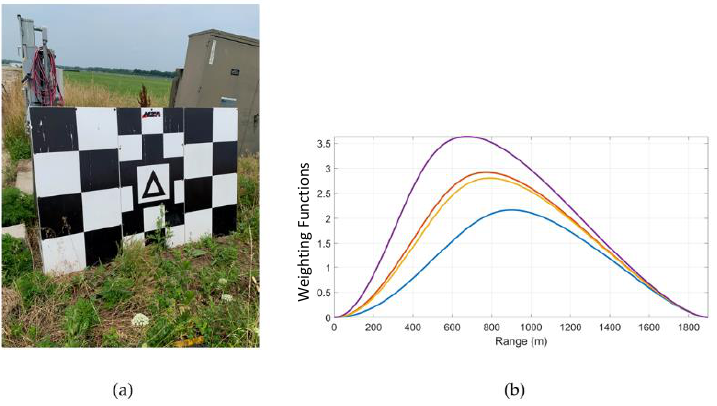
Figure 2. Differential tilt variances. ( a ) DELTA target board; ( b ) Weighting functions (dimensionless) for 4 different feature point separations. z = 0 at the DELTA location.